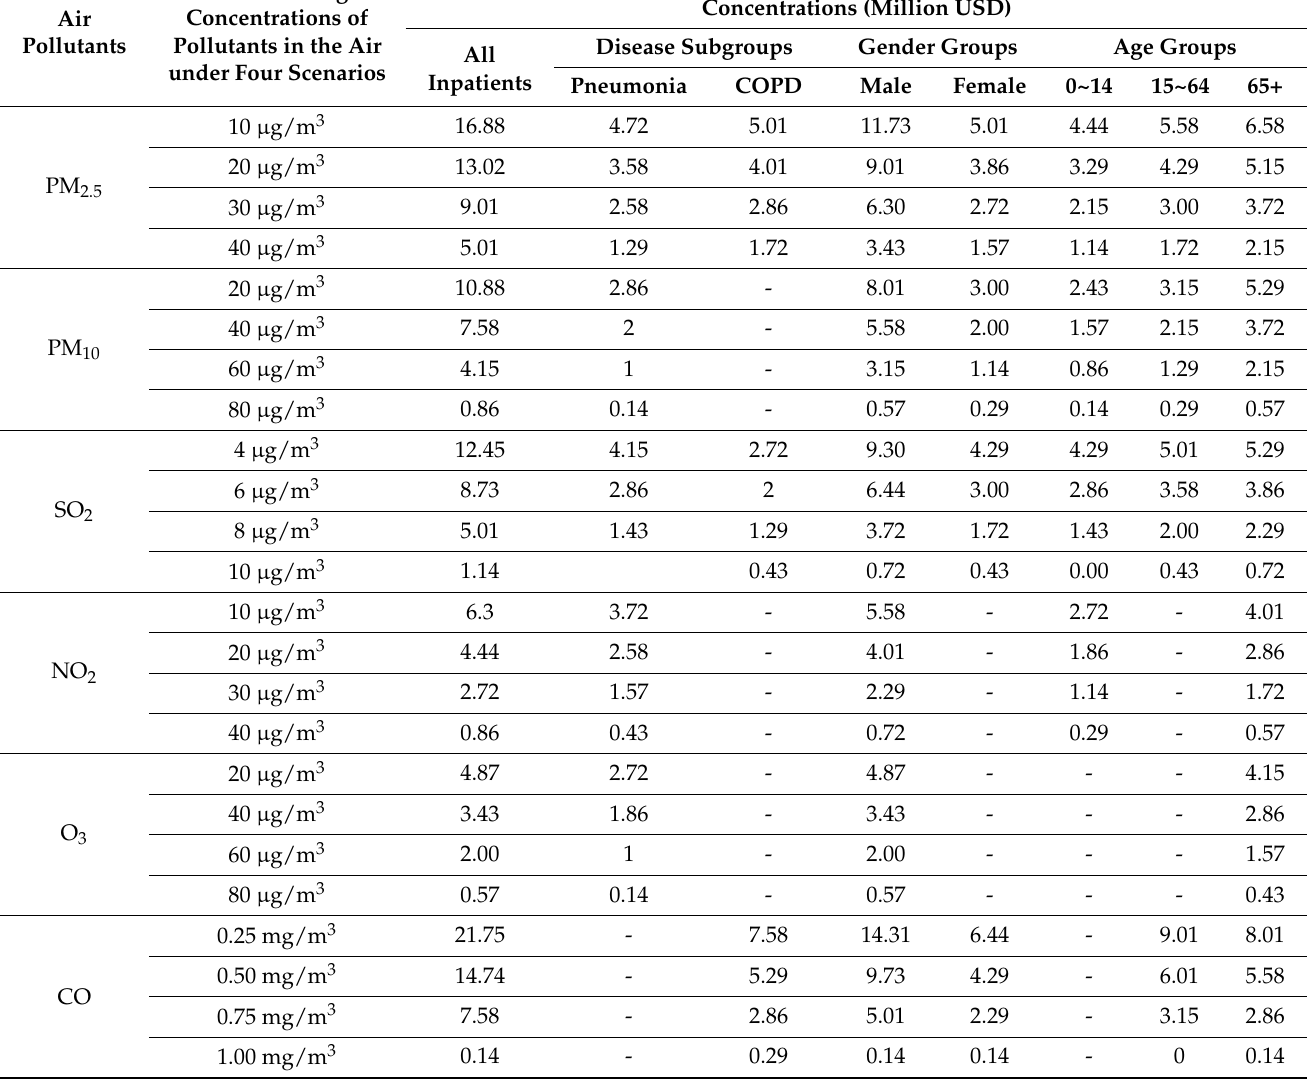
Table 12. Scenario analysis of evitable economic losses at relatively low levels of air pollutant concentrations in Wuhan.